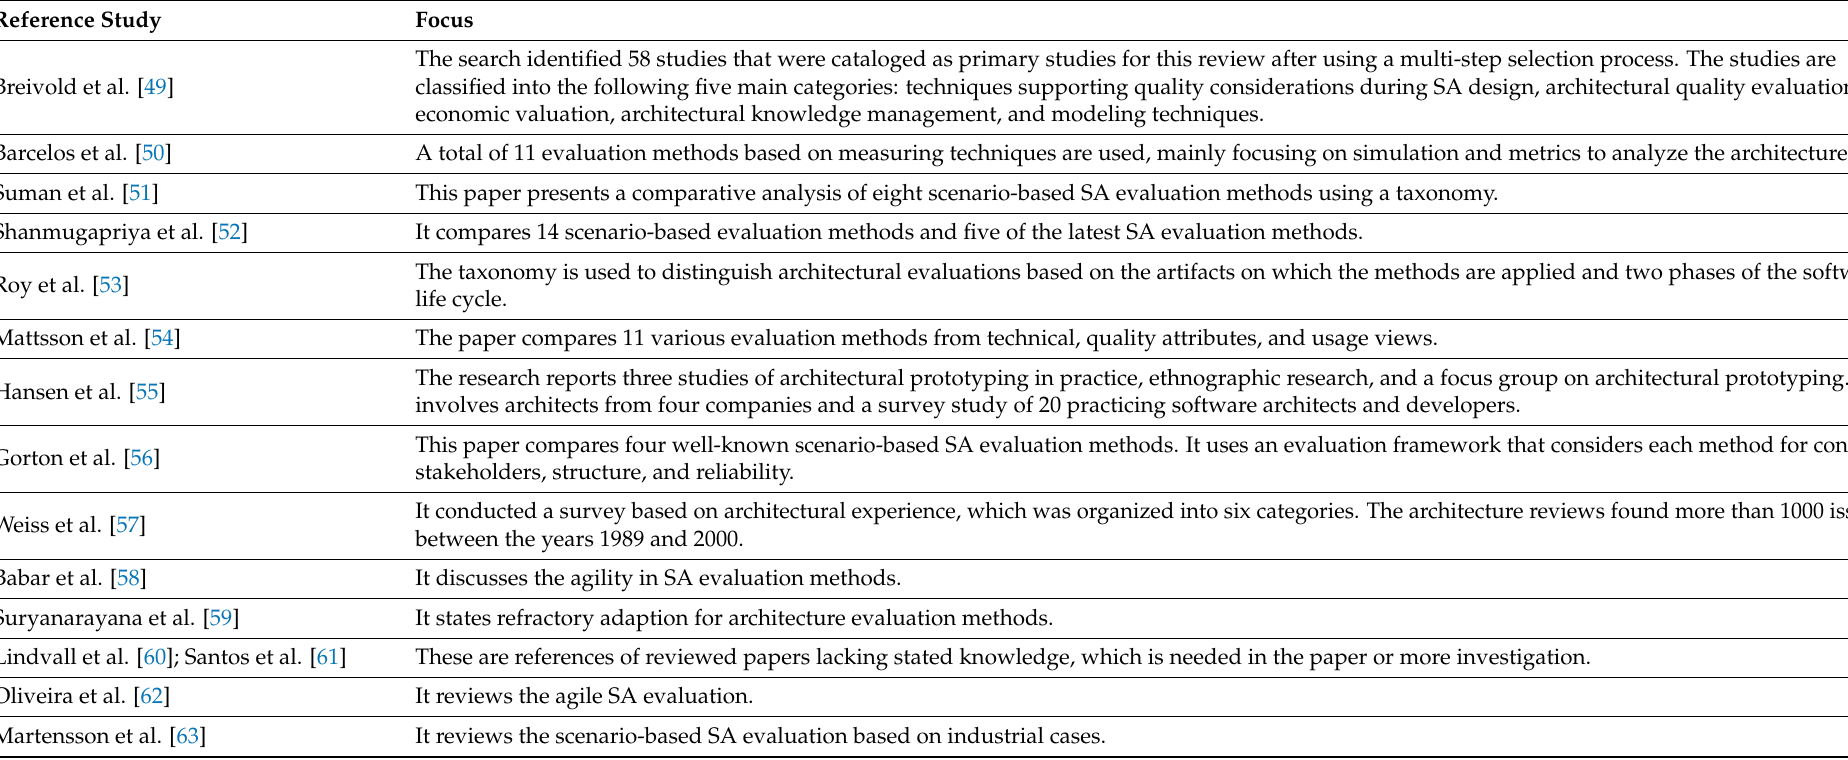
Table 1. The selected published papers in SA